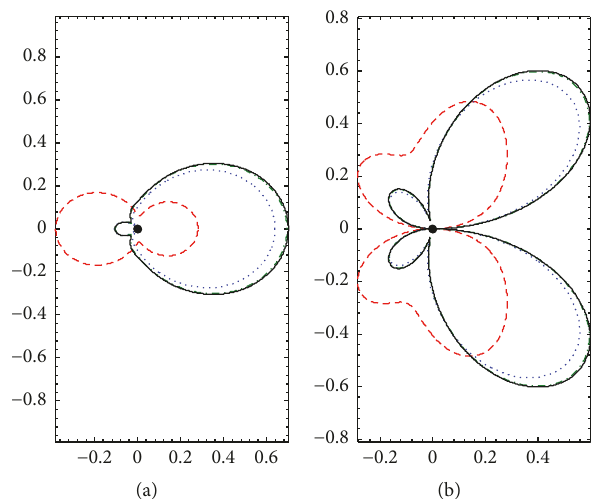
Figure 5: The far-field scattering magnitude patterns of the scattered (a) P- and (b) SV-waves by a fiber with a partially imperfect bonding to the matrix, under a plane P-wave incidence (dashed line: 𝐾 𝑛 /𝐾 ∗ 𝑛 = 𝐾 𝑡 /𝐾 ∗ 𝑡 = 10 −1 ; dotted line: 𝐾 𝑛 /𝐾 ∗ 𝑛 = 𝐾 𝑡 /𝐾 ∗ 𝑡 = 10 0 ; dash dotted line: 𝐾 /𝐾 ∗ = 𝐾 /𝐾 ∗ = 10 1 ; solid line: perfect 𝑛 𝑡 𝑛 𝑡